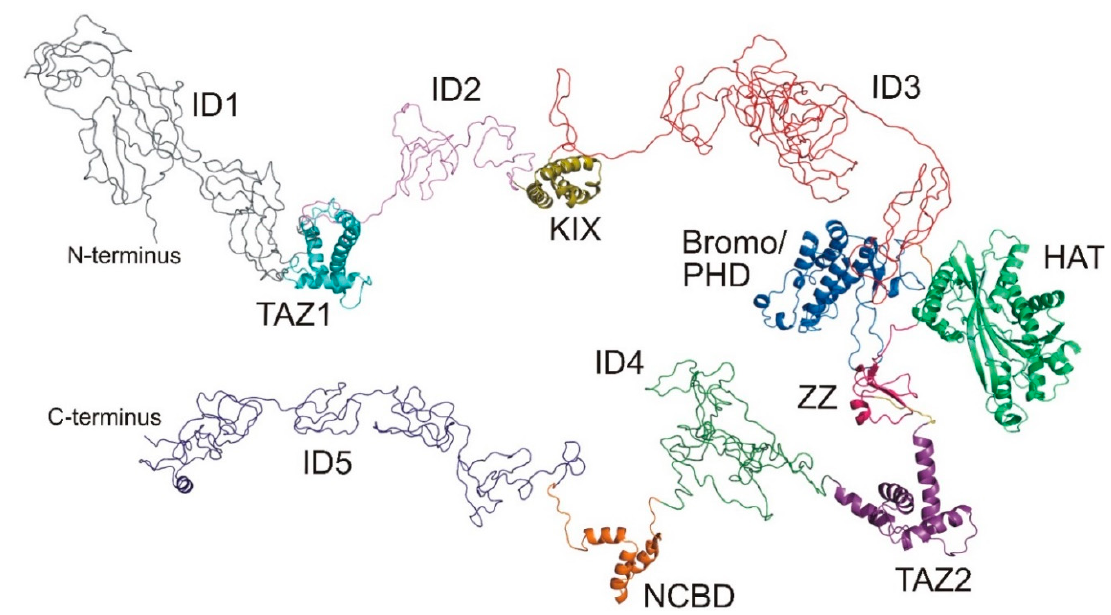
Figure 4. Structural organization of human CBP: ID1 (gray), TAZ1 (cyan, PDB ID: 1U2N), ID2 (violet), KIX (gold, PDB ID: 2LQI), ID3 (red), Bromo and PHD (light blue, PDB ID: 4N4F), HAT (light green, PDB ID: 3BIY), ZZ (pink, PDB ID: 1TOT), TAZ2 (purple, PDB ID: 2KJE), ID4 (green), NCBD (orange, PDB ID: 2KKJ) and ID5 (blue). Disordered regions have been generated using the IntFOLD web resource [40].